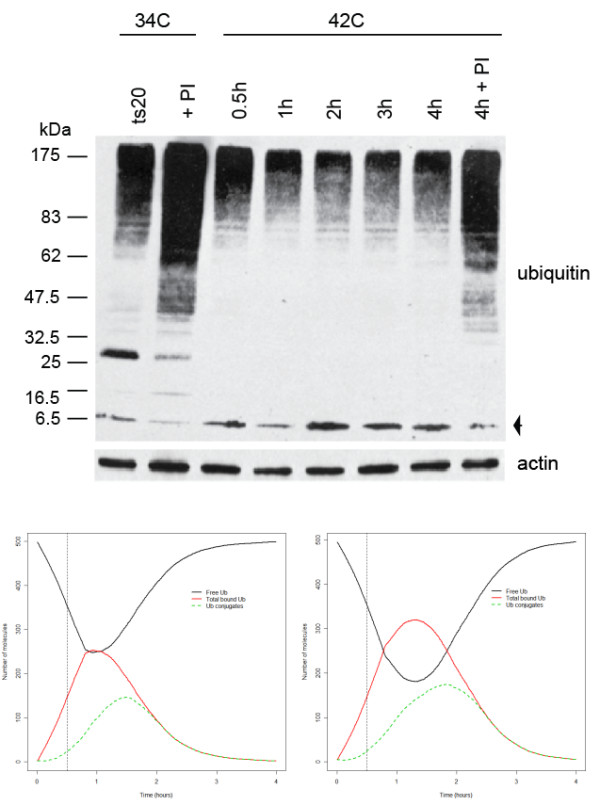
Shutting down E1 activity in ts20 cells. (a) Time course of conversion of conjugates into monomeric ubiquitin pool Western blot analysis of cell extracts from ts20 cells cultured either at 34°C or 42°C for the indicated time with an antibody recognizing ubiquitin. The analysis revealed a detectable conversion of ubiquitin conjugates into monomeric ubiquitin in cells cultured at 42°C for 2 hours. Maintaining the cells at 42°C for an additional 1 or 2 hours did not significantly enhance the conversion of conjugates into the monomeric pool. The addition of proteasome inhibitor in the culture medium of cells cultured at 42°C blocked the conversion of poly-ubiquitinated conjugates and resulted in their enhanced detection. The membrane was re-probed with an actin specific antibody which served as a loading control (boxed panel). (b) Model output E1 activity was blocked at time = 0.5 hours by setting the parameter k62 = 0 at this time point (indicated by dashed vertical line on the graph). All other parameters as in Tables 2 and 3. The simulations were repeated 100 times and the curves show the mean values. Ub conjugates includes all ubiquitinated misfolded protein both free and bound to the proteasome; total bound Ub includes ubiquitin bound to E1 and E2 enzymes in addition to ubiquitinated misfolded proteins. (c) As (b) except ten-fold lower DUB activity on polyubiquitinated proteasome-bound substrates (k68 = 1.0 × 10-6)